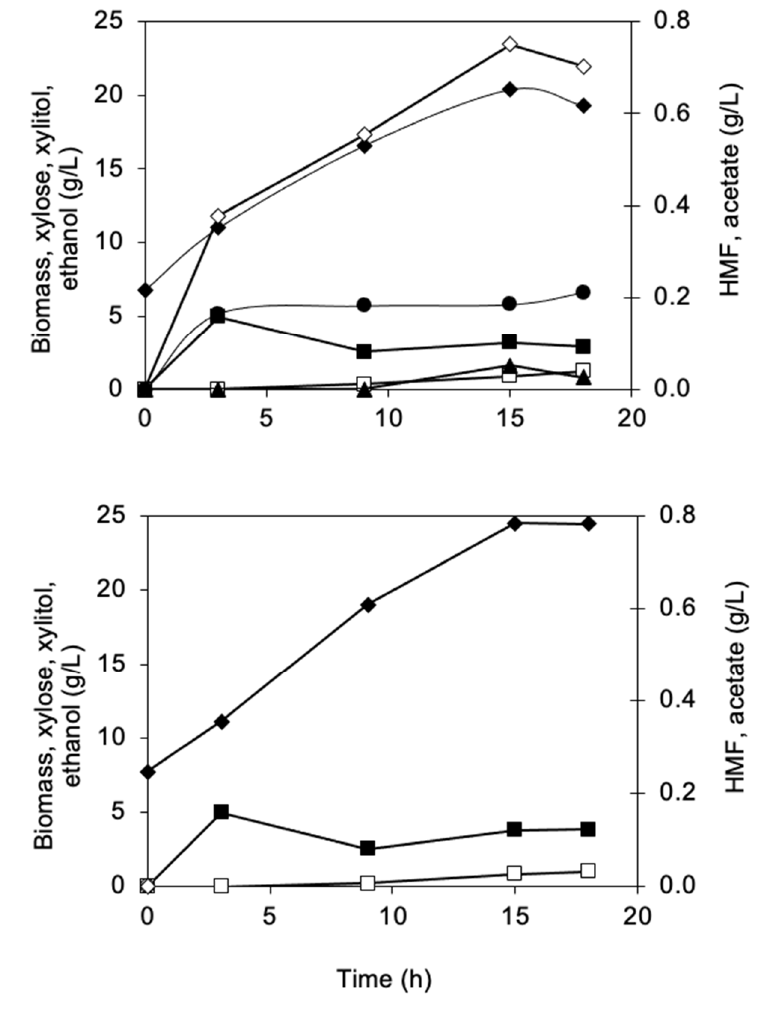
Figure 2. Profile of fed-batch cultivation with S. cerevisiae TMB3500 in spruce hydrolysate (top) and in sugar mixture (bottom). First y -axis: biomass ( ♦ ), xylose ( ■ ), xylitol (□), ethanol ( ▲ ); second y - axis: acetate (◊) and HMF (●). Duplicate experiments showed similar results and the figure shows one of the representative profiles for each cultivation.